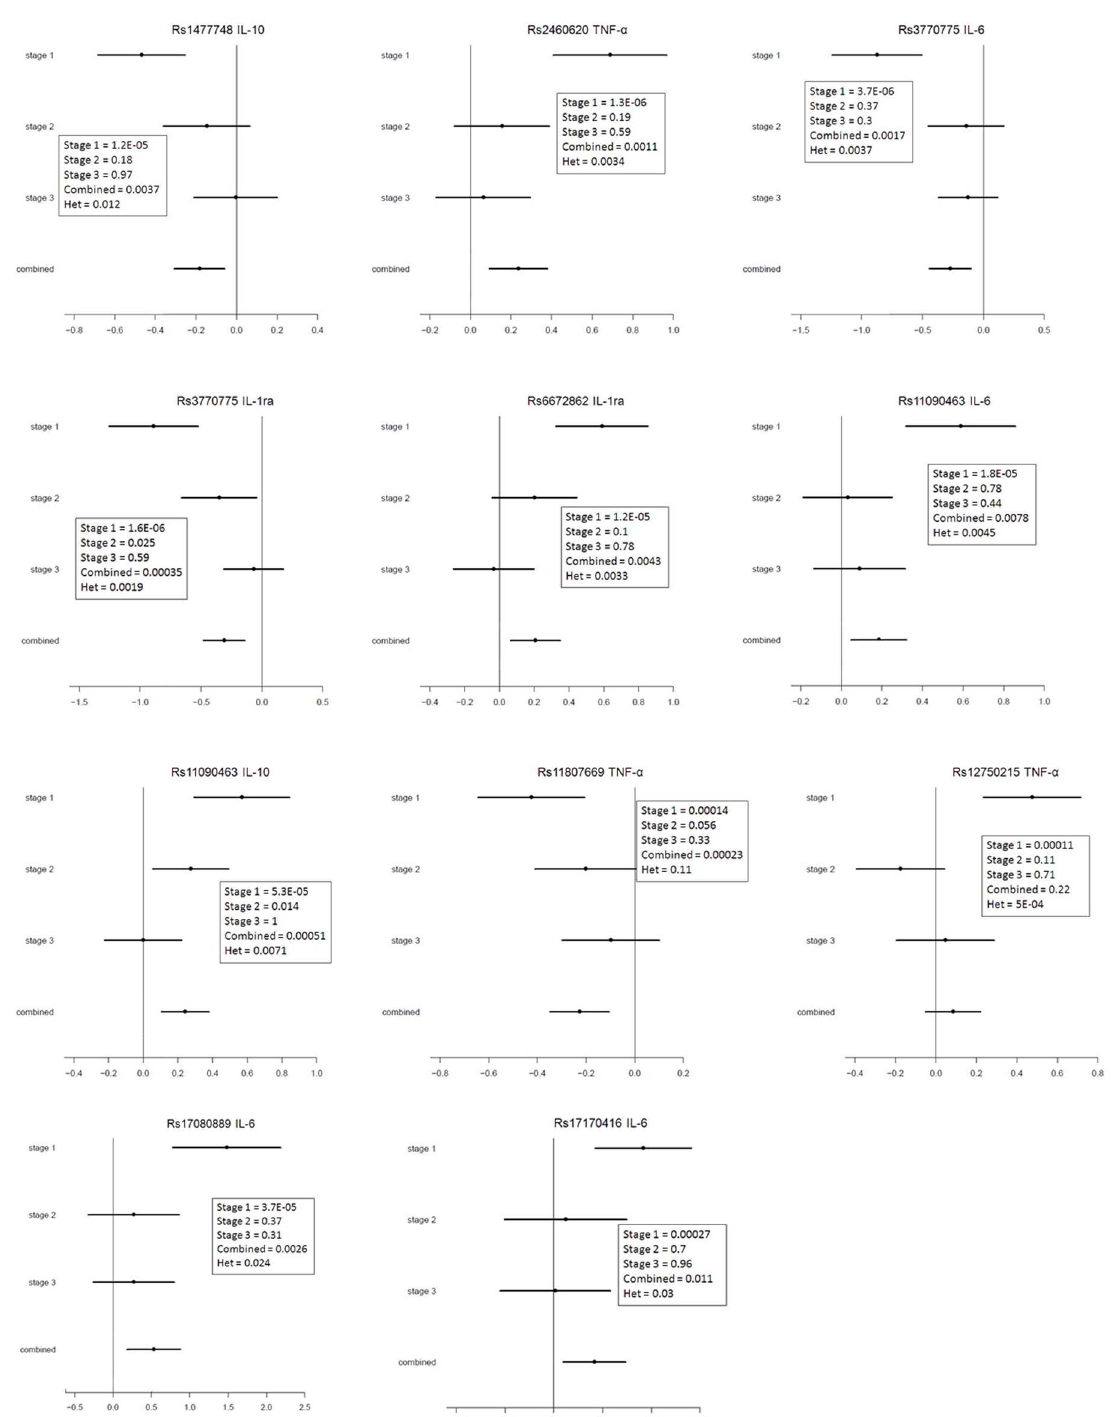
Figure 3. Forest plots of meta-analysis of each selected SNP on the cytokine production. The x-axis represents the estimated effect sizes in mean differences. The horizontal lines show the stage-specific estimated effect sizes and the corresponding 95% confidence intervals of the natural logarithmic mean differences. The solid vertical line at 0 means no difference in effect size.